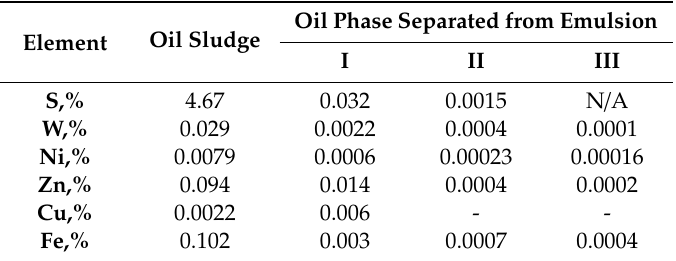
Table 4. Contents of sulphur and metals in oil phase after low-temperature hydrogenation in sorbing electrochemical matrices.